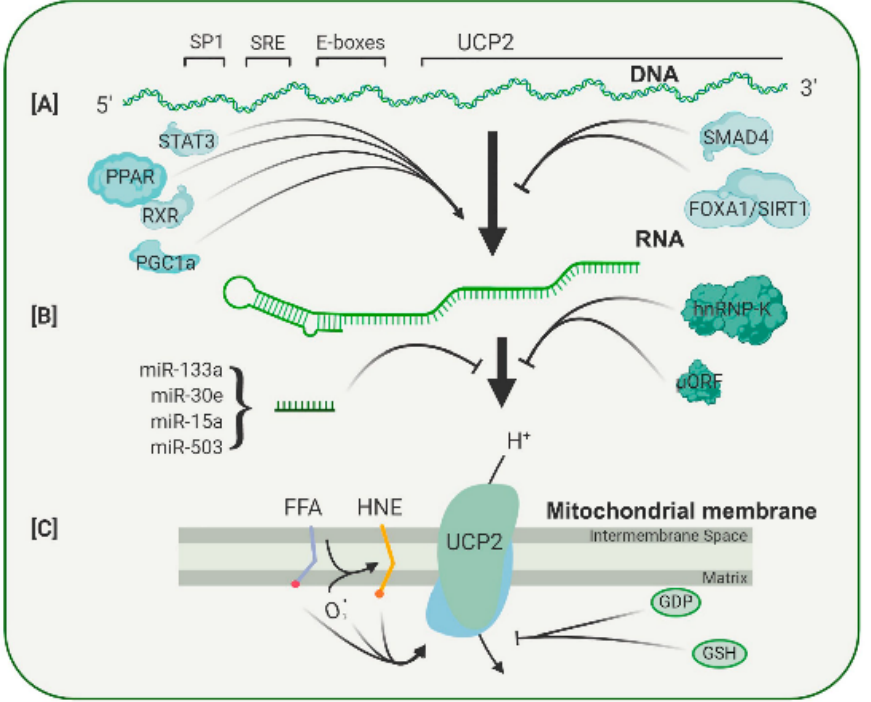
Figure 3. Diagrammatic representation of the multiple levels of regulation of UCP2 expression and activity. ( A ) UCP2 transcription is enhanced or repressed through binding of several transcription factors to sites in its promoter. ( B ) Translation of the UCP2 transcript is controlled by an upstream open reading frame (uORF), a number of microRNAs and RNS binding proteins, such as hnRNP-K. ( C ) The UCP2 protein can be activated by a number of compounds, including free fatty acids and lipid peroxides, and can be inhibited by the nucleotide GDP and by glutathione. A more complete discussion of the regulation of UCP2 expression can be found in Reference [2] from which this figure is